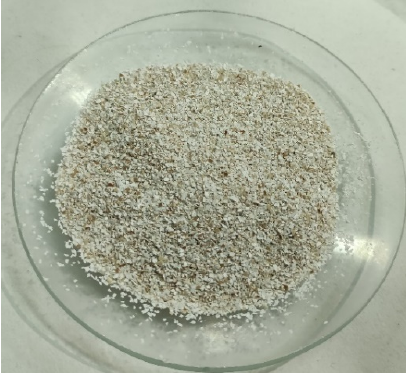
Figure 1. Chicken eggshells sample.